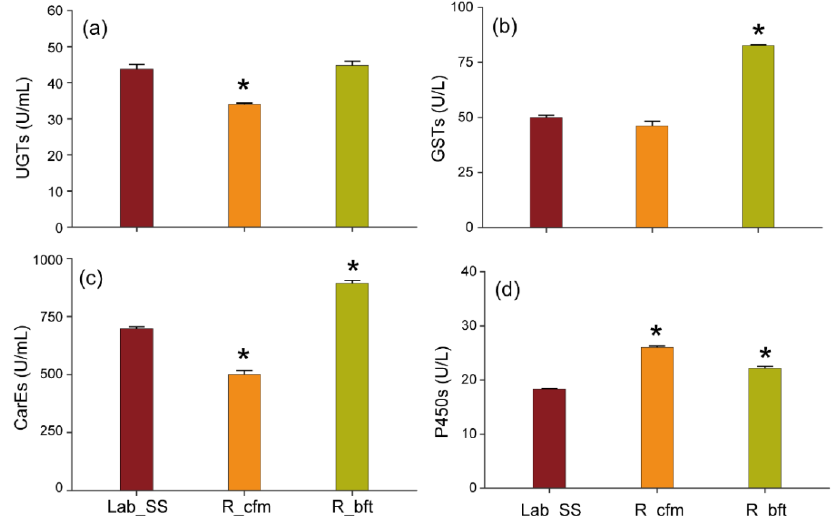
Figure 2. The enzyme activity in the cyflumetofen ‐ (R_cfm) and bifenthrin ‐ resistant (R_bft) strains of T. urticae . The activity of UDP ‐ glycosyltransferases (UGTs) ( a ), glutathione ‐ S ‐ transferases (GSTs) ( b ), carboxylesterases (CarEs) ( c ) and cytochrome P450 monooxygenases (P450s) ( d ). * indicates the significant difference (p < 0.05) compared with the susceptible strain (Lab_SS).